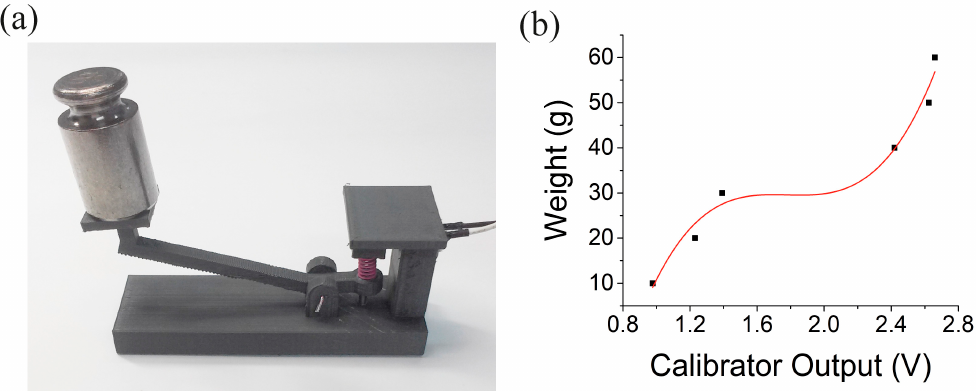
Figure 5. T-module sensor calibration. ( a ) Image of the t-module calibration tool. ( b ) Response curve from the calibration tool.